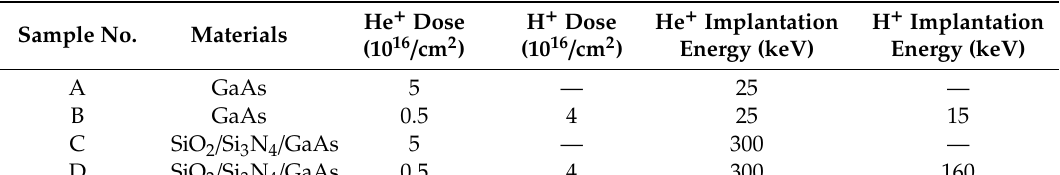
Table 1. Implantation parameters for the four samples.